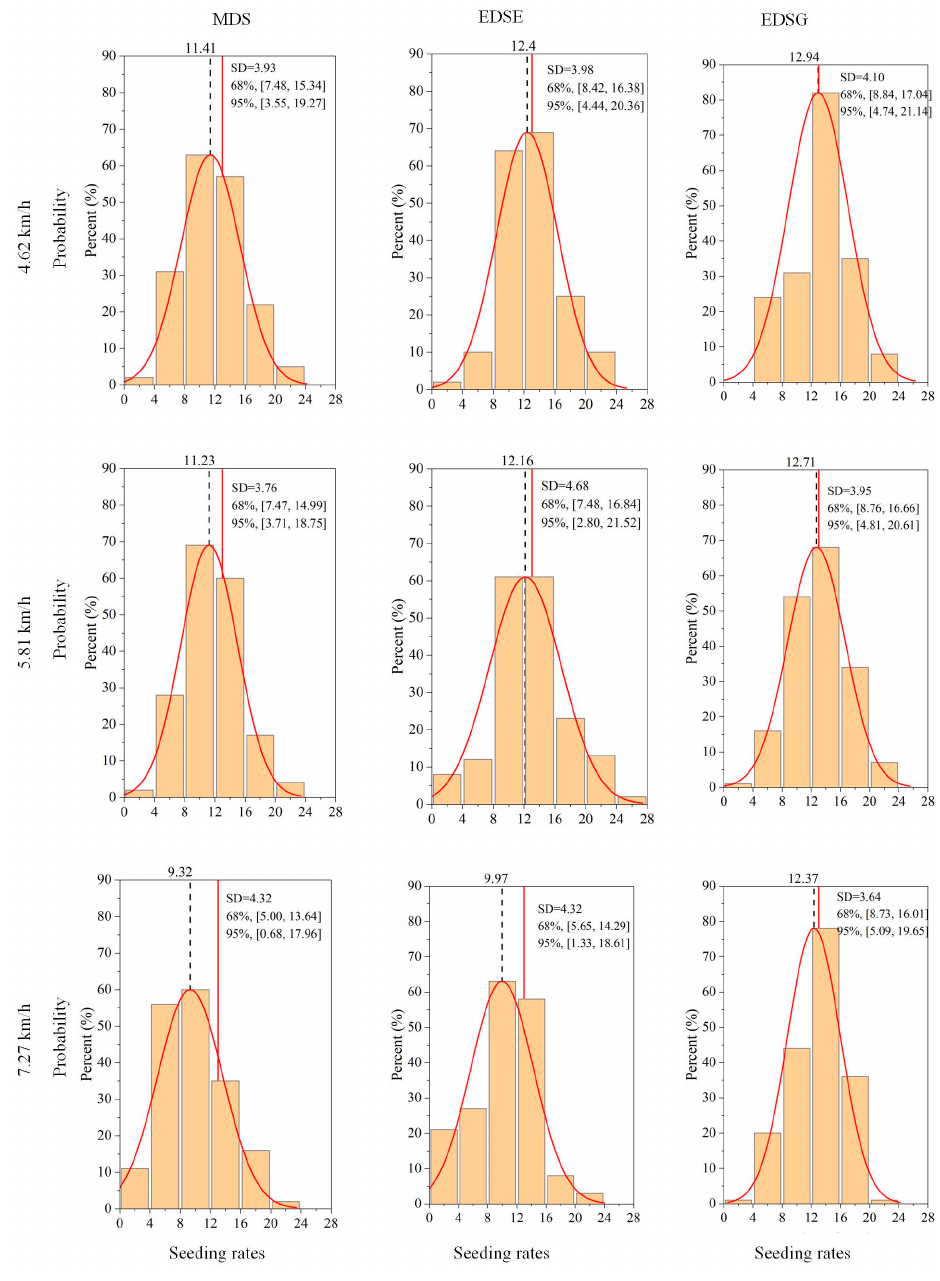
Figure 6. Probability density functions of the seeding rates with the MDS, EDSE, and EDSG for the three operating speeds. SD is the standard deviation. The vertical red line represents the target value of 13. The vertical dotted lines are the mean value (u) of the function. The confidence interval [u − SD, u + SD] and at a probability of 68% and [u − 2SD, u + 2SD] at the probability of 95% were displayed. The columnar represents the proportion of the seeding rate against the corresponding confidence interval on the horizontal